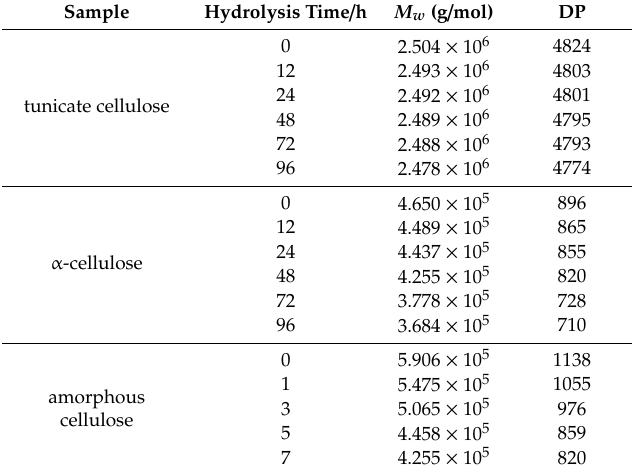
Table 2. Molecular weight ( M w ) and polymerization degree of tunicate cellulose, α -cellulose and amorphous cellulose at di ff erent enzymatic hydrolysis